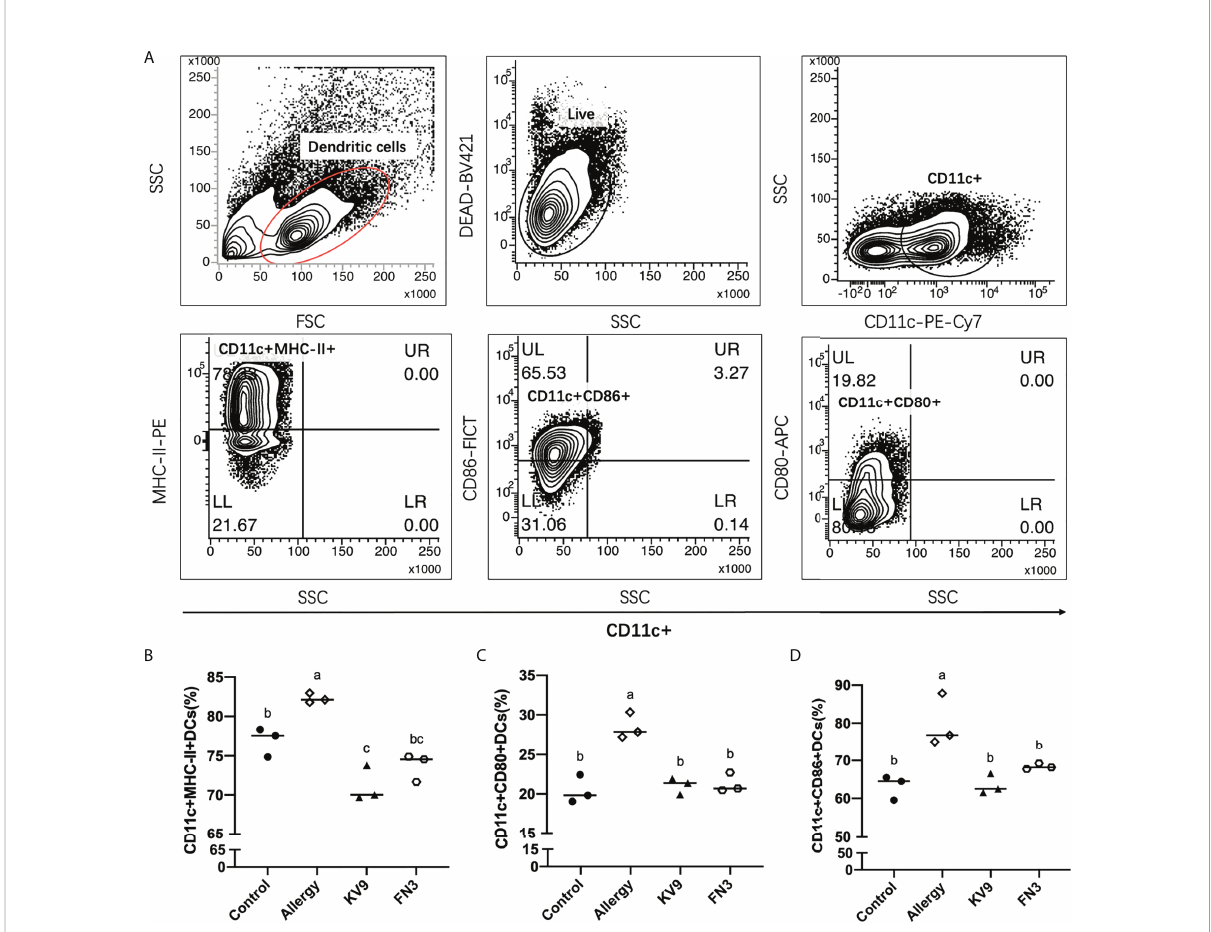
FIGURE 5 The effect of probiotics on DCs. The gating strategy (A) and the effect of oral administration of KV9 and FN3 on populations of CD11c+MHC-II +DCs (B) , CD11c+CD80+DCs (C) , and CD11c+CD86+DCs (D) in the intestinal lymph node from different groups of mice. Identical lowercase in the fi gure indicates the lack of signi fi cance ( p <